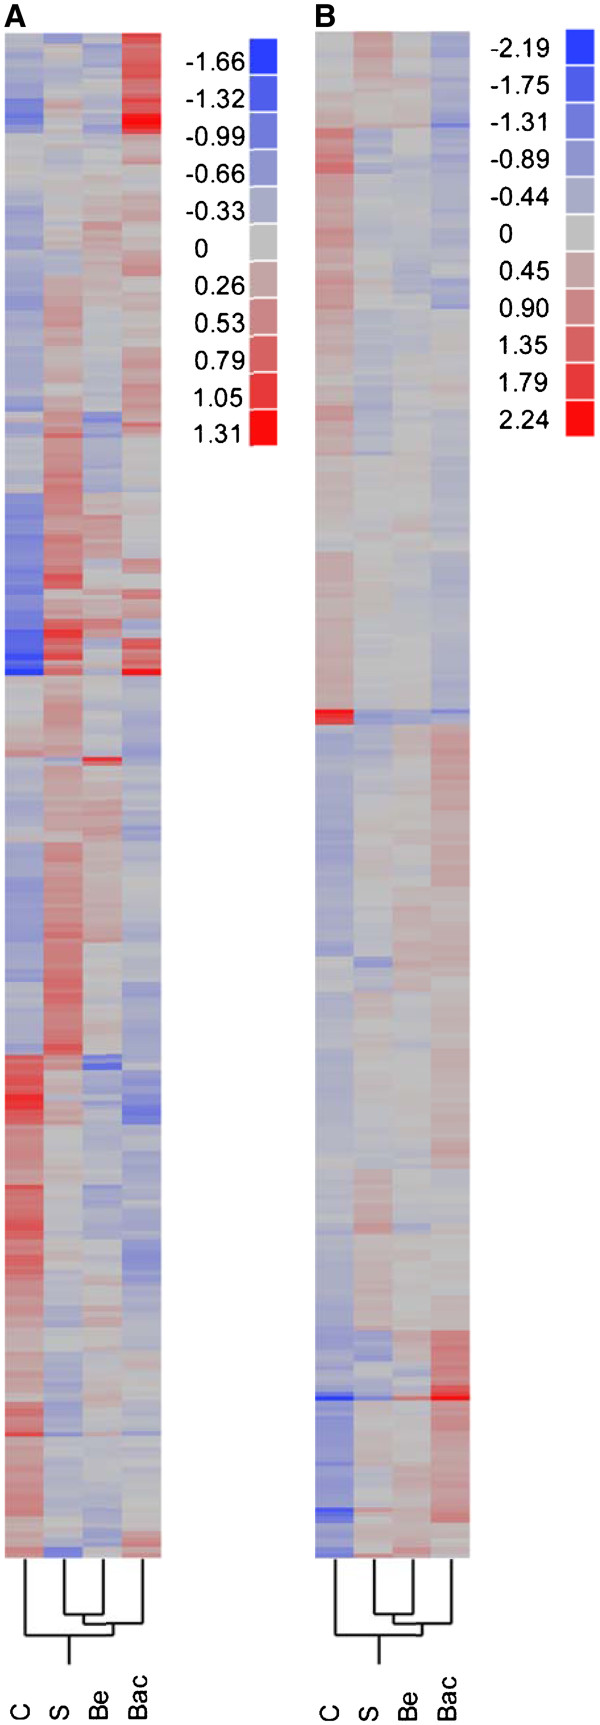
Hierarchical clustering of significantly regulated genes. We performed hierarchical clustering analysis on the 302 significantly, differentially expressed transcripts (FDR<0.01) similarly regulated in Colony 1 (A) and Colony 2 (B). Both colonies demonstrated the same overall grouping for experimental treatments: saline (S) and bead (B) injected bees formed a sister group and were closer in transcript expression to bacteria (Bac) injected bees than controls (C). Control and bacteria-injected bees had the most disparate transcript expression. Colours denote differences in log2 expression relative to the mean expression across the four treatment groups, according to the scale shown.